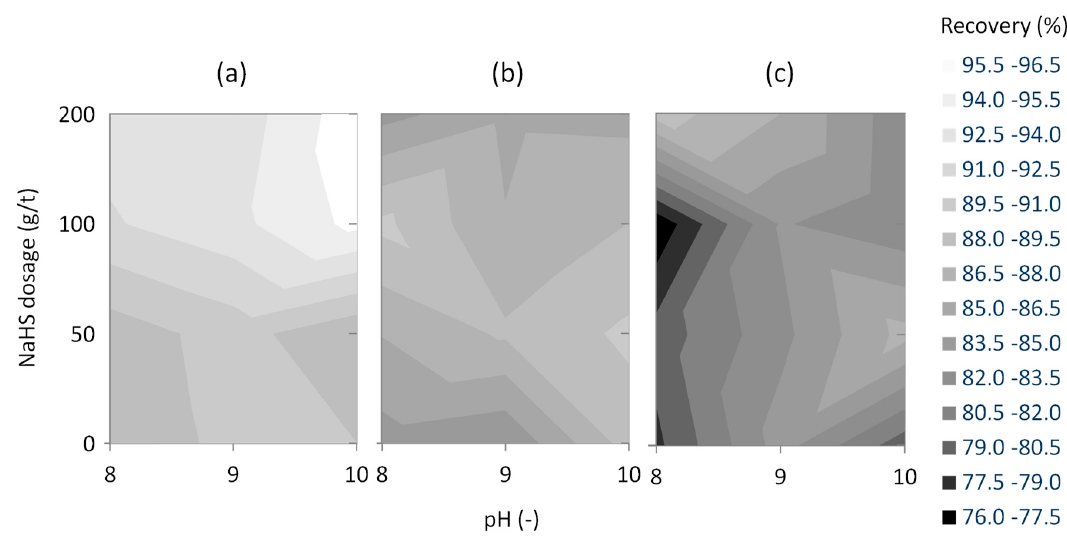
Figure 5. Final recoveries of ( a ) chalcocite, ( b ) bornite, and ( c ) chalcopyrite without NaHS and with NaHS dosages of 50 g/t, 100 g/t, and 200 g/t at pH 8, 9, and 10.